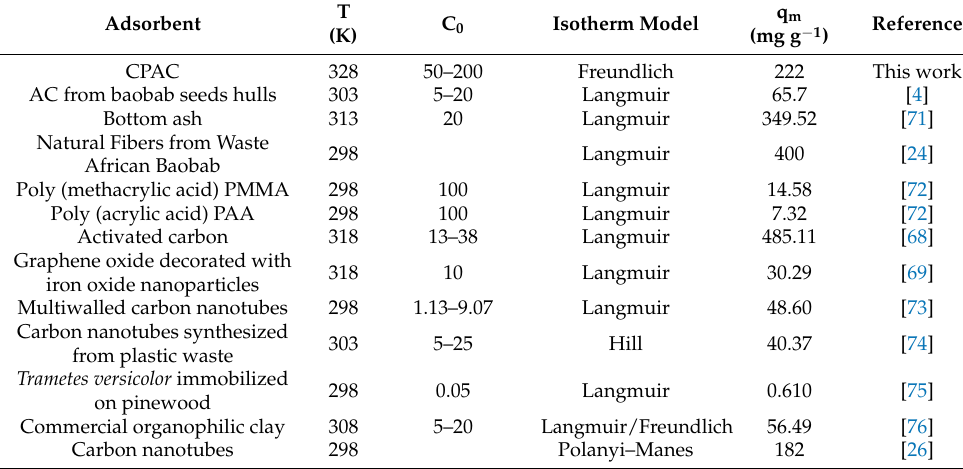
Table 2. Adsorbents developed and used for removing the pesticide Diuron from aqueous media: parameters and maximum adsorption capacities compared to CPAC.